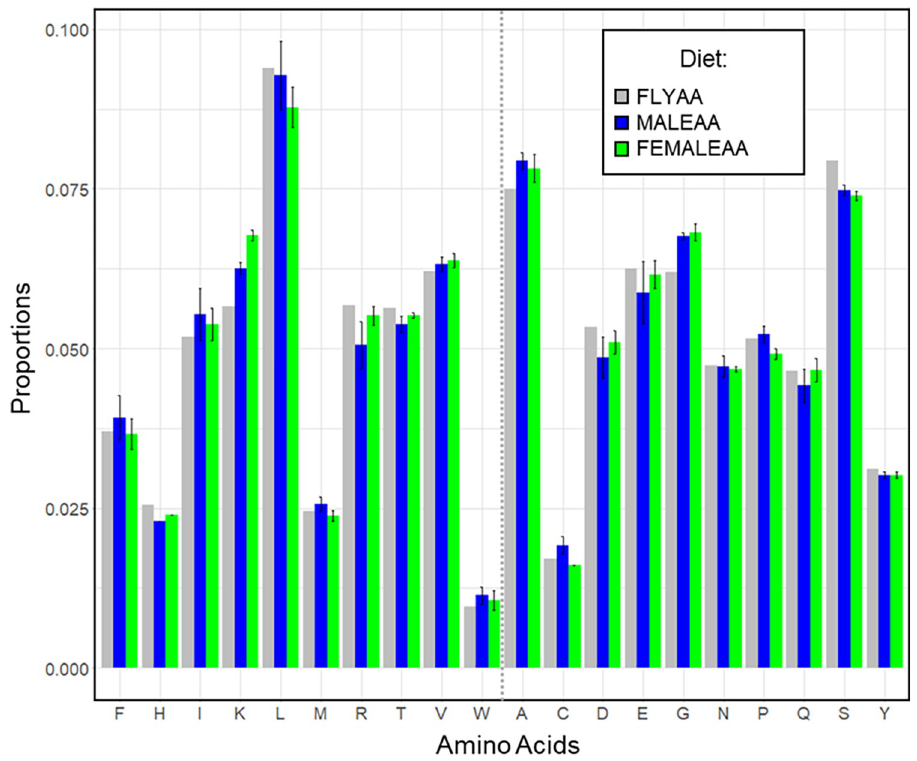
Fig 1. Comparison of the exome matched and transcriptome weighted AA ratios. Proportion of each AA in the exome matched [14] and transcriptome-weighted exome matched diets (MALEAA and FEMALEAA). In these diets, the average proportions of AAs have been generated after weighting each protein’s contribution by size and its average gene expression in male and female transcriptomes, respectively. The dotted grey line separates the essential (left) from the non-essential (right) AAs. IUPAC single-letter AA codes are shown. Error bars display the standard deviation from weighting the AA ratios by each of the replicate transcriptome profiles from FlyAtlas 2 and modENCODE that were available for males or